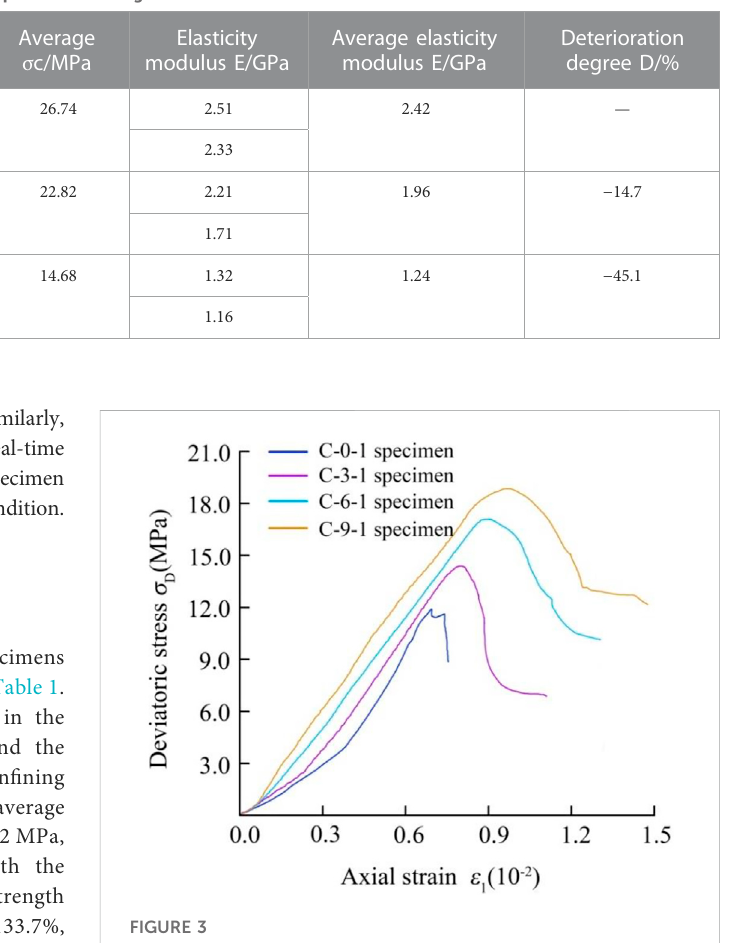
TABLE 2 Compression test results of coal specimen under different amplitude unloading conditions.